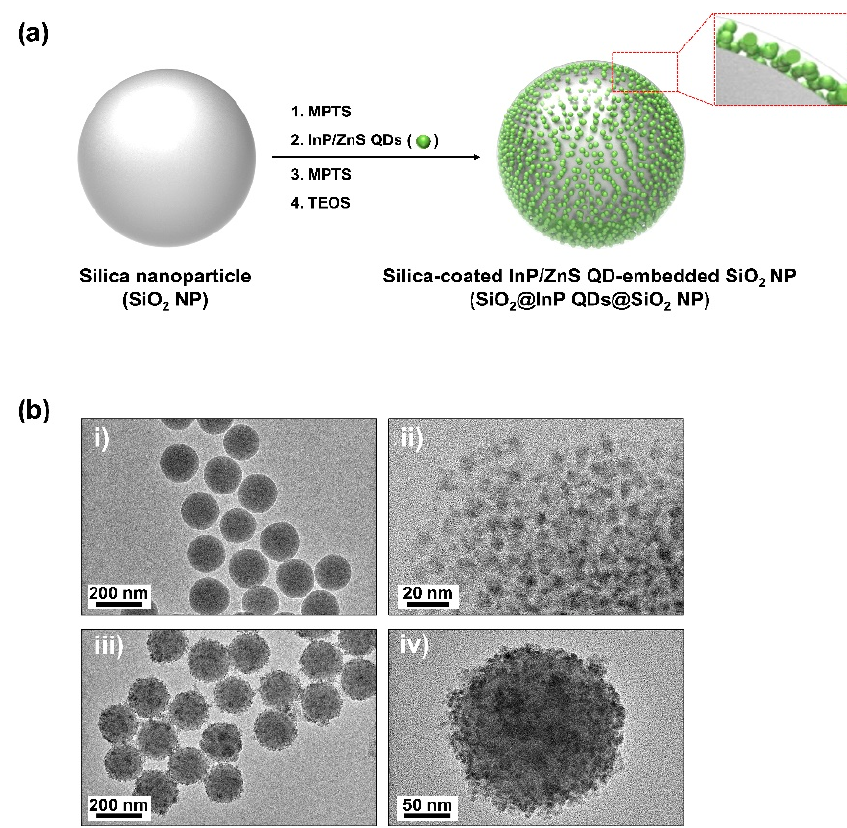
Figure 1. Fabrication of SiO 2 @InP QDs@SiO 2 NPs. ( a ) Schematic illustration for fabrication